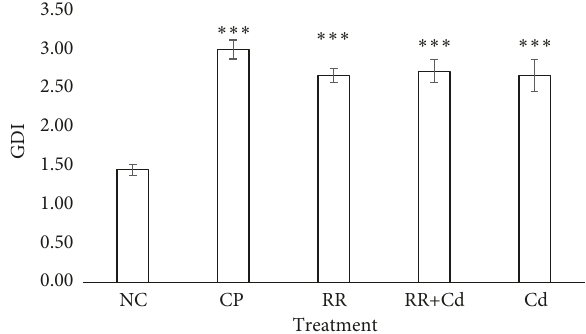
Figure 4: Analysis of DNA damage measured by comet assay in peripheral blood erythrocytes of Cnesterodon decemmaculatus exposed to different treatments, as indicated by the genetic damage index (GDI). Treatments: NC (negative control, MHW); CP (pos- itive control, 5 mg cyclophosphamide/L); RR (surface water of the Reconquista River); RR+Cd (surface water of the Reconquista River with 2 mg Cd/L); Cd (2 mg Cd/L). ∗ ∗ ∗ Significant differences with respect to control values at p < 0.001. Number of individuals analyzed in each treatment: 8-10.